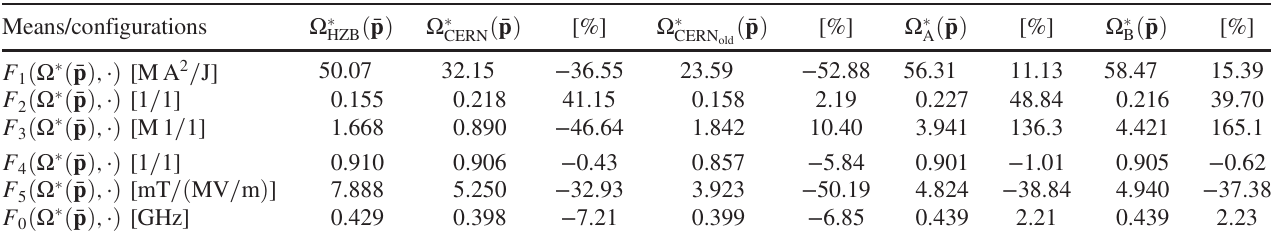
TABLE V. Results of the MO optimization for the first mode — objective space a . Means/configurations